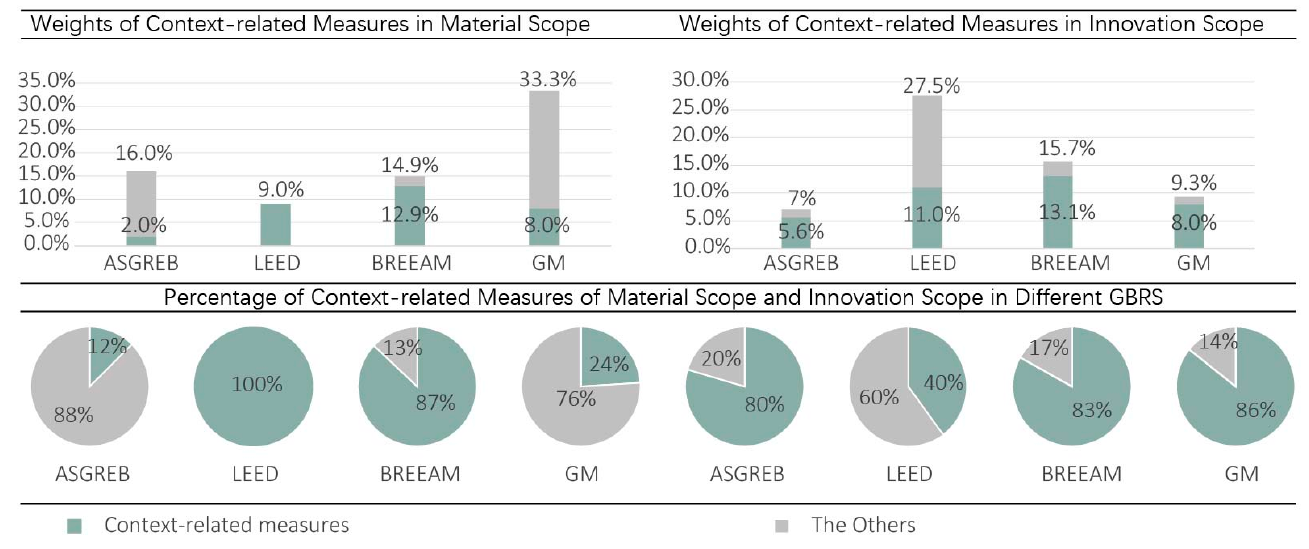
Figure 10. Analysis of context-related items.